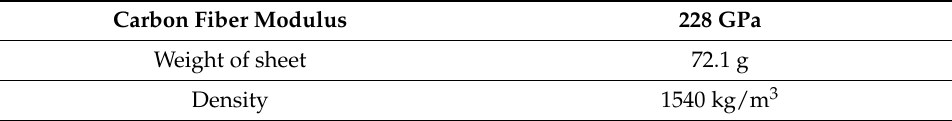
Figure 3. ( a ) The spherical steel ball, which measured 20 mm in diameter and weighed 33 g. ( b ) The steel ball wrapped in black tape.